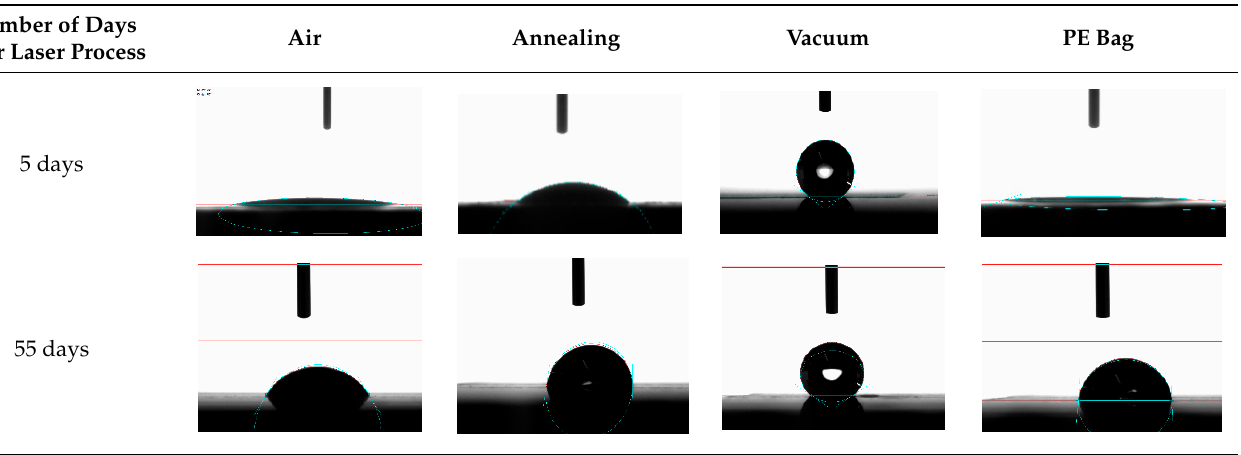
Table 6. Comparison of a droplet images for structure B after 5 and 55 days.